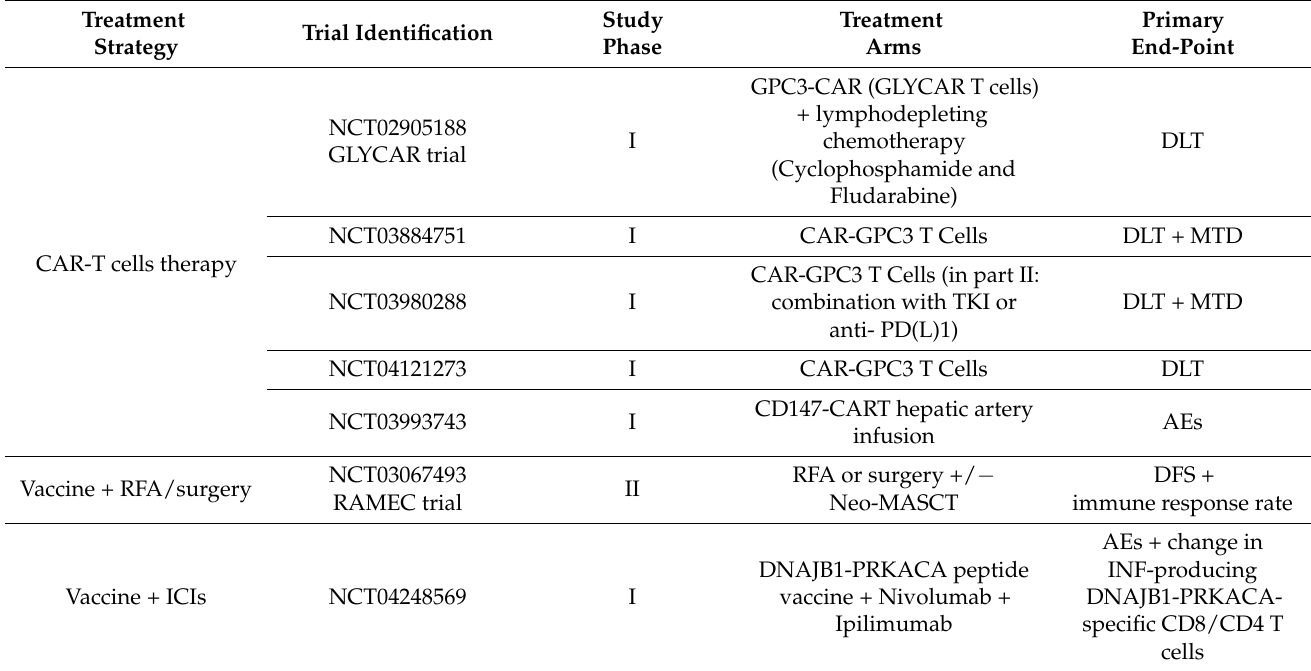
Table 4. Ongoing clinical trials of CAR-T and vaccine for